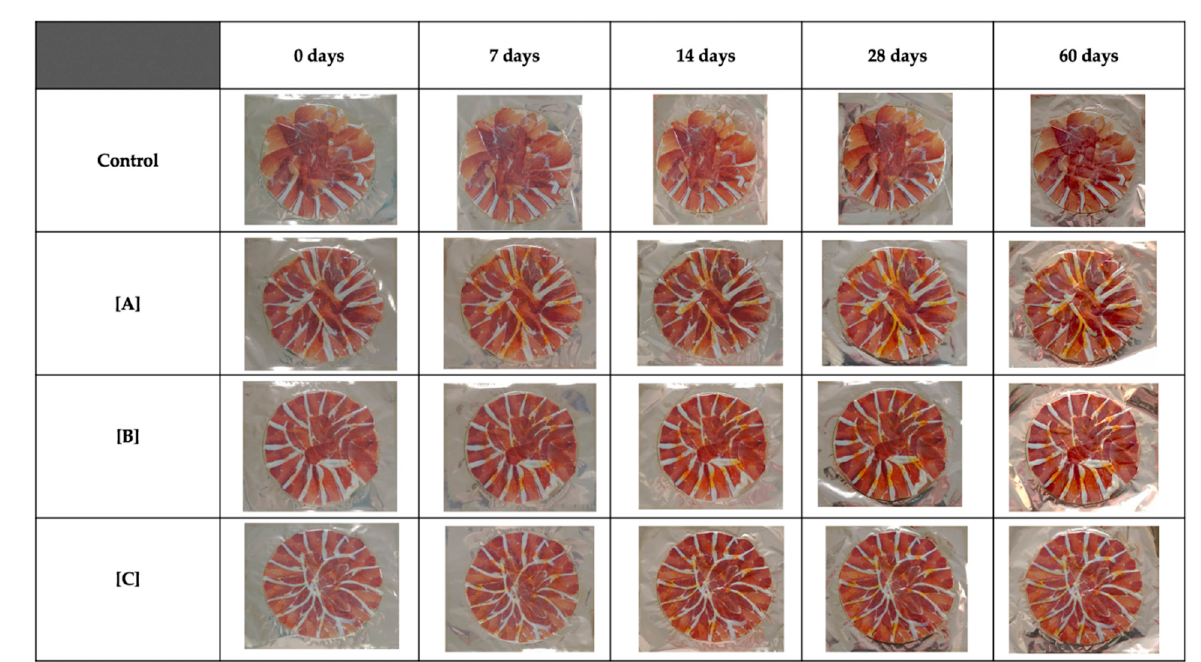
Figure 1. Visual appearance of the samples in each group (CONTROL: sample without saffron; A: 0.055% w/w ; B: 0.035% w/w ; C: 0.015% w/w ) during the storage time period (0, 7, 14, 28 and 60 days). Scale (1:20).